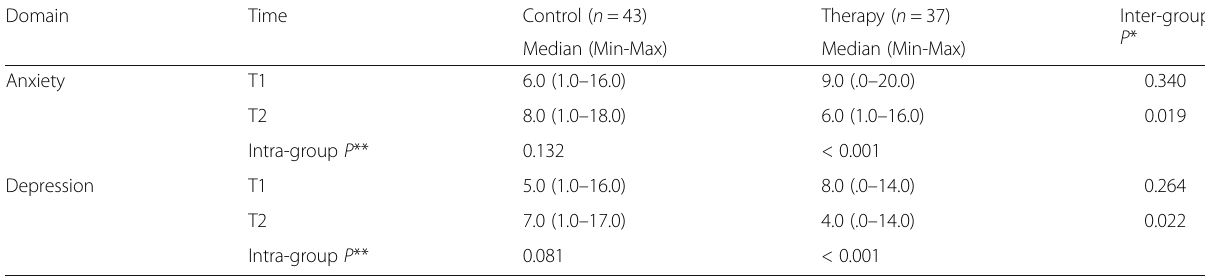
Table 5 Anxiety and depression scores of SLE patients in control and therapy groups over time